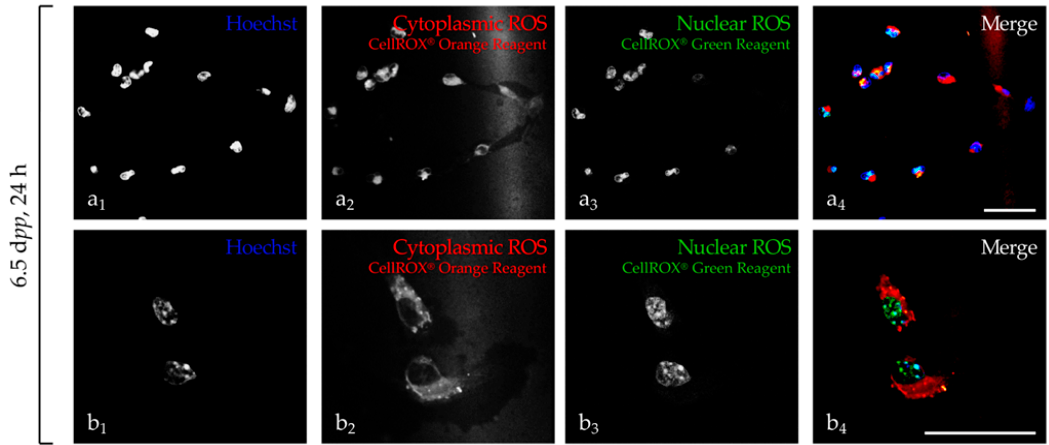
Figure 1. Evaluation of reactive oxygen species (ROS) probes localization in 6.5 dpp mice testicular cell suspension. ( a , b ) ROS signal localization after 24 h of in vitro culture of testicular cells. Testicular cells, previously incubated (30 min) with ROS probes exhibited an orange fluorescence signal present in the cytoplasm ( a 2 , b 2 ), while the green signal ( a 3 , b 3 ) was superposed ( a 4 , b 4 ) to Hoechst nucleus staining ( a 1 , b 1 ) confirming their cellular specific localization. To visualize ROS generation in testicular cells, the preparation was illuminated with a 488 nm (green) or 532 nm (orange) wavelength light. The green fluorescence emission was detected from 500–530 nm and the orange fluorescence emission from 550–580 nm. Photomicrographs were acquired with a × 63 objective and optical zoom ( × 1 for ( a 1 – a 4 ); × 2 for ( b 1 – b 4 )) was adjusted to obtain a large view ( a 1 – a 4 ) or high magnification ( b 1 – b 4 ) of labeled testicular cells. The scale bar represents 40 µ m. dpp, days post-partum; h, hour; H 2 O 2 , hydrogen peroxide; ROS, reactive oxygen species.